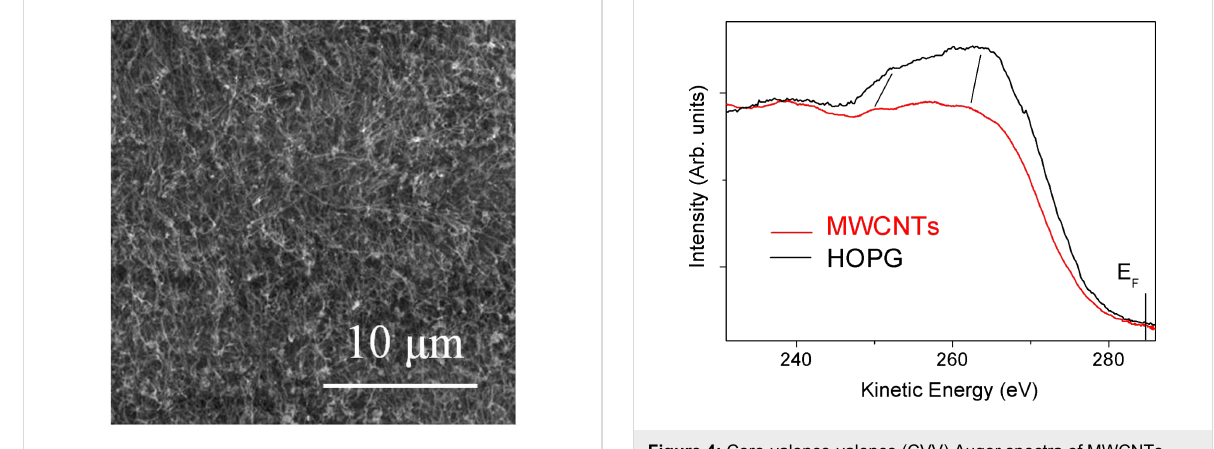
Figure 2: SEM image of the MWCNTs after growth on a stainless- steel substrate. The MWCNTs are randomly oriented, and no traces of other carbonaceous materials were detected in the large scanned area.